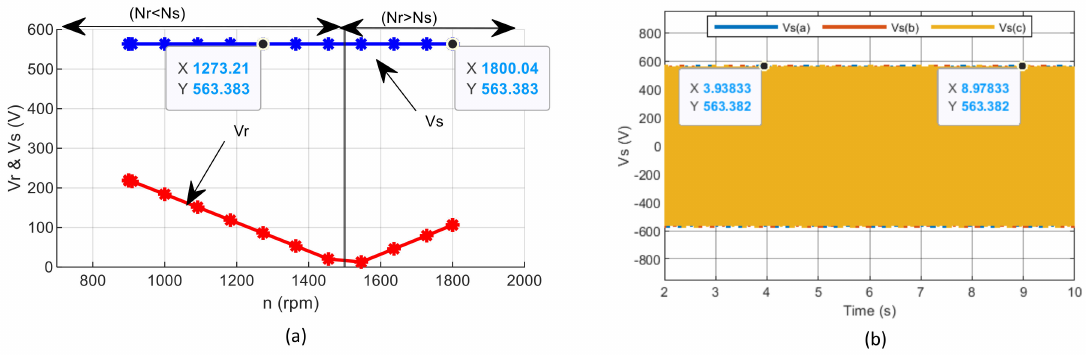
Figure 9. ( a ) Calculated stator voltage; ( b ) Stator voltage of the designed system. The values of rotor voltages are calculated to be 86.0158 V, which is similar to the simulated SS value of 87.1958 V for a speed of 1273.21 rpm. Again, for a speed of 1800 rpm, the calculated value of stator current is 106.294 V and the SS value of 104.47 V is within comparable limits. Figure 10a,b show the values for